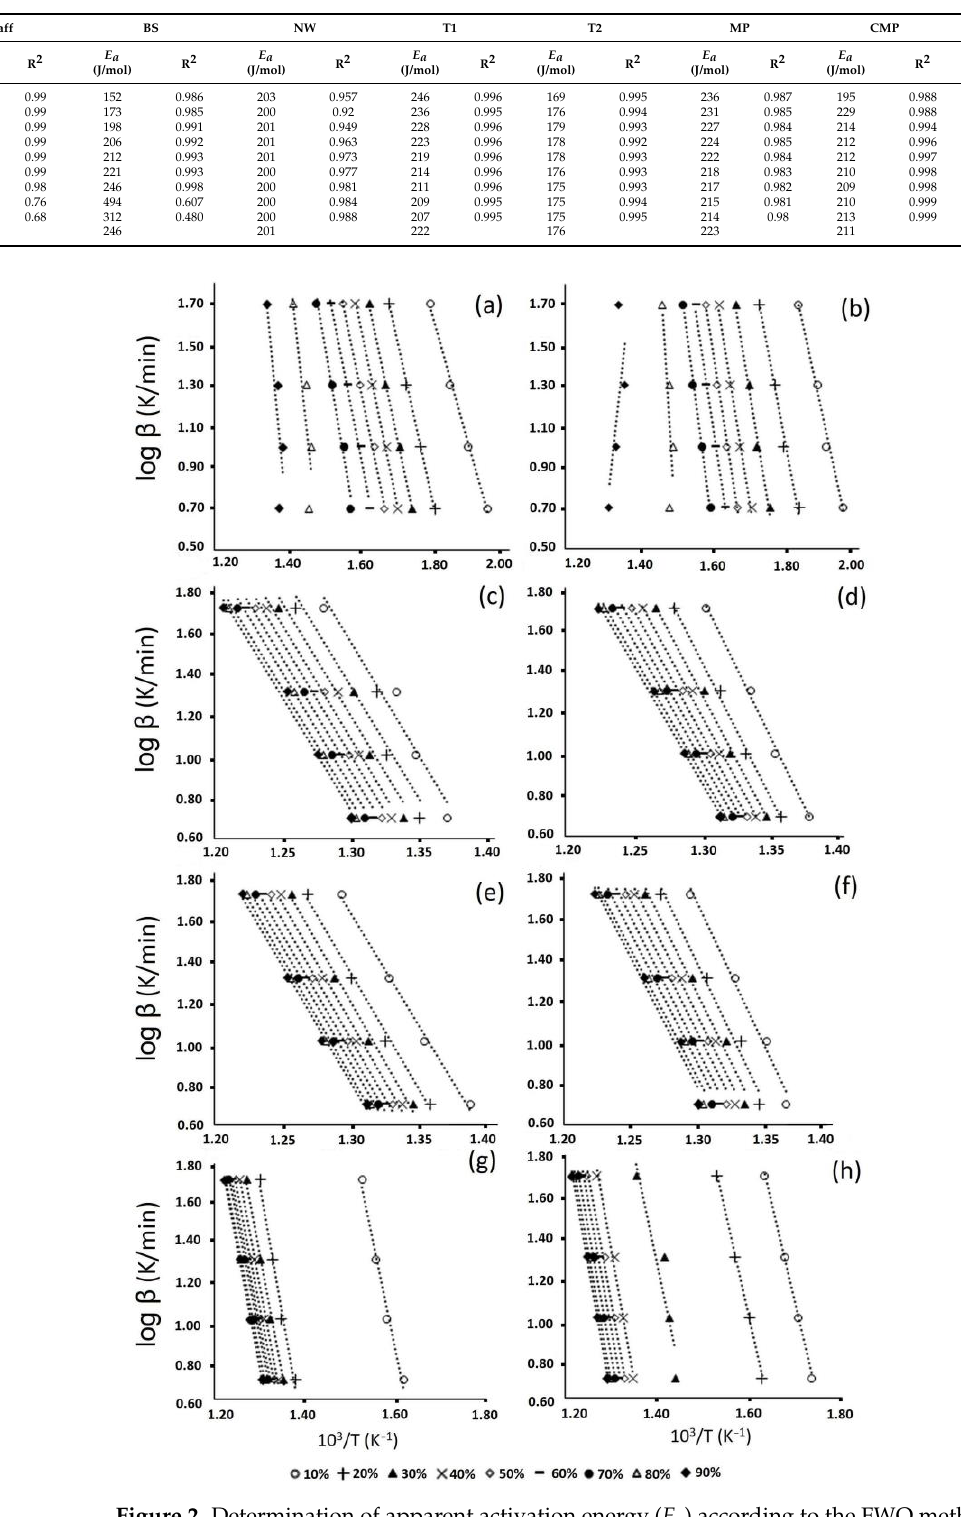
Figure 2. Determination of apparent activation energy ( E a ) according to the FWO method at heating rates ( β ) of 5, 10, 20, and 50 °C/min for ( a ) Chaff, ( b ) BG straw, ( c ) NW, ( d ) T1, ( e ) T2, ( f ) MP, ( g ) CMP, and ( h )